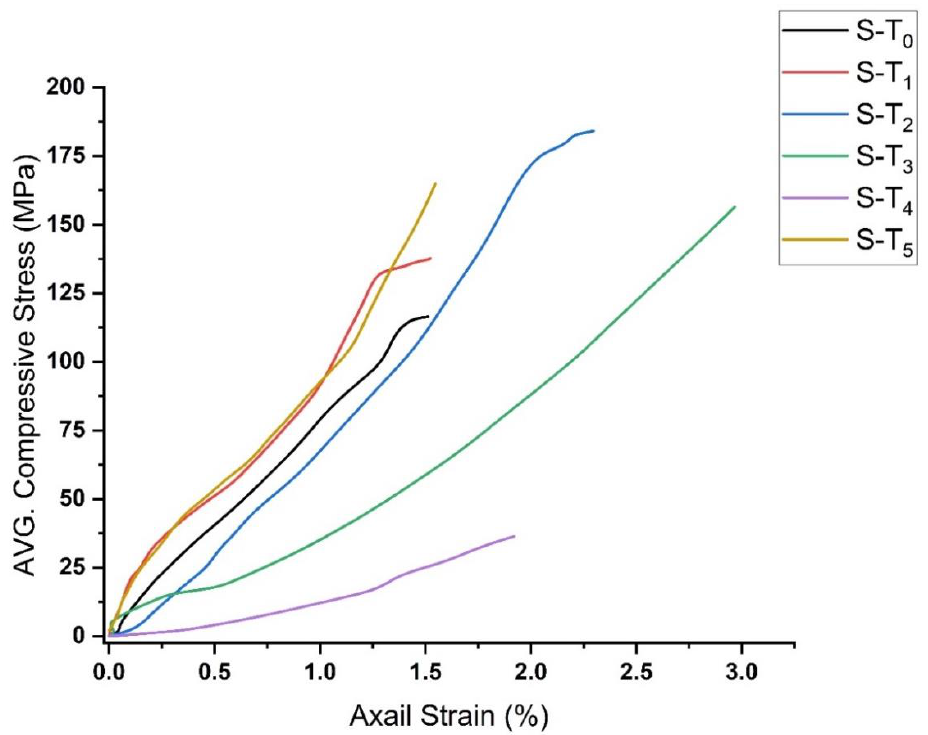
Figure 17. Comparison of the stress–strain curves of the investigated specimens at different temperatures (S-T 0 ; specimens at 22 °C, S-T 1 ; specimens at 200 °C, S-T 2 ; specimens at 400 °C, S-T 3 ; specimens at 600 °C, S-T 4 ; specimens at 800 °C, S-T 5 ; specimens at 500 °C.